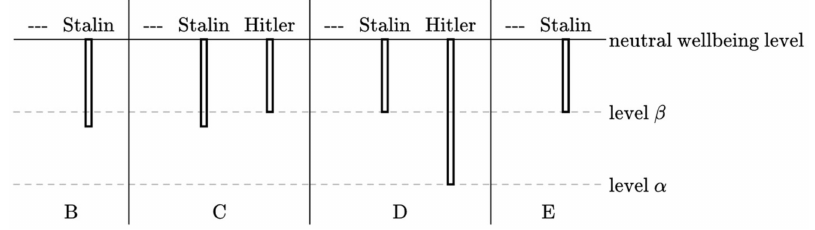
Figure 4. Desert-neutrality as